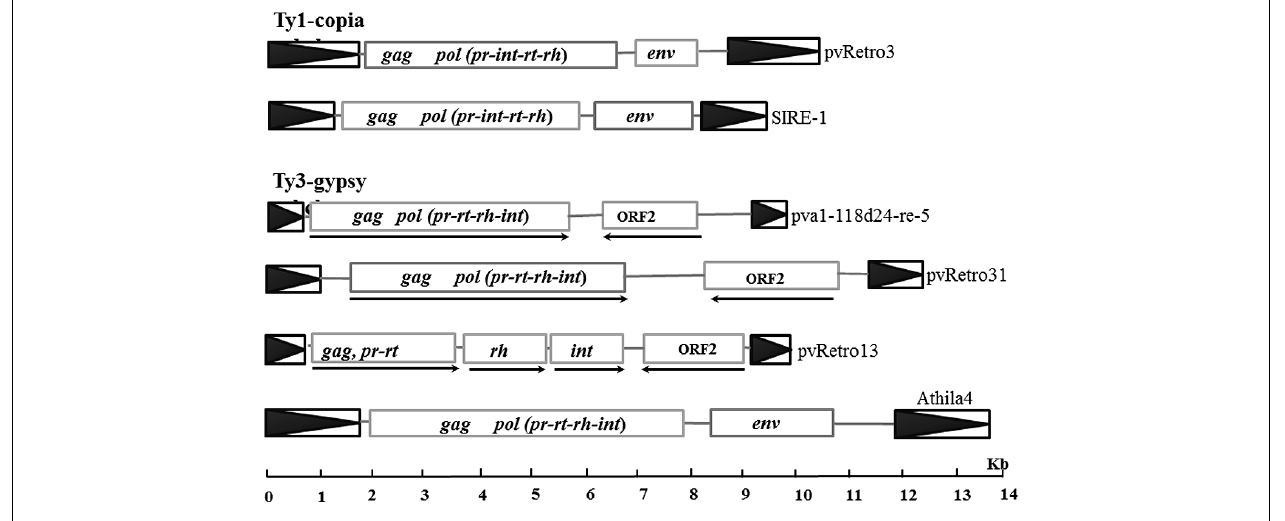
FIGURE 2 | Sequence structures of different LTR retrotransposons. Boxes with black triangles represent transposon LTRs. Rectangles indicated open reading frames (ORF) encoding retrotransposases or other proteins and arrows indicate the transcription orientations for retroelements with